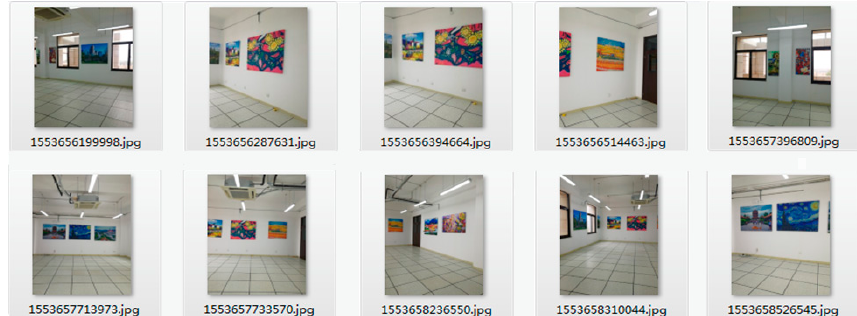
Figure 15. Ten experimental smartphone positioning images. Table 1. Comparison of positioning results.